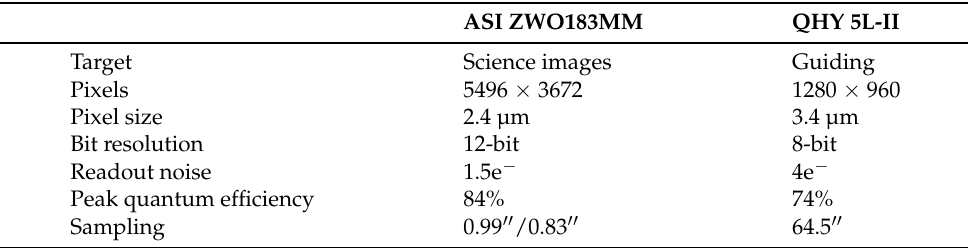
Table 2. SUTO-Solar cameras.